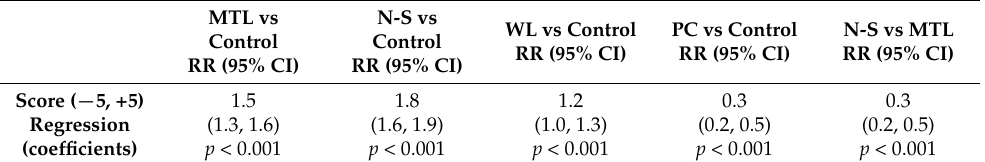
Table 4. Multiple regression analysis results—association of global food score between FOPL group and control (adjusted for design factors and covariates).